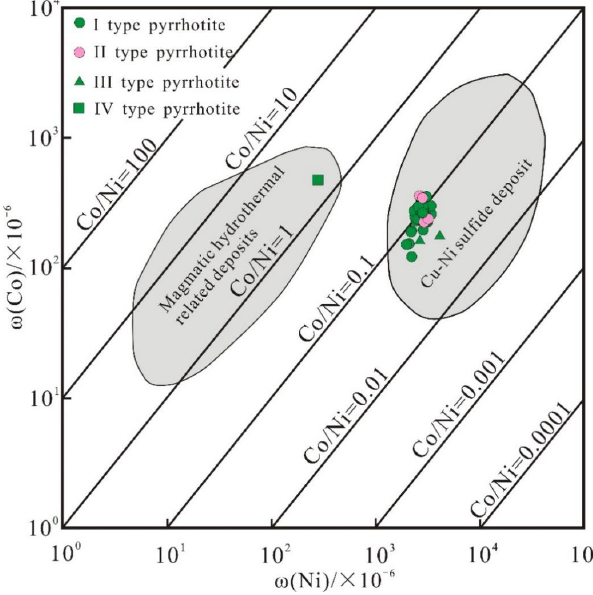
Figure 8. Co–Ni genetic discrimination diagram of the pyrrhotite from the Huangyangshan deposit (modified after [37]).